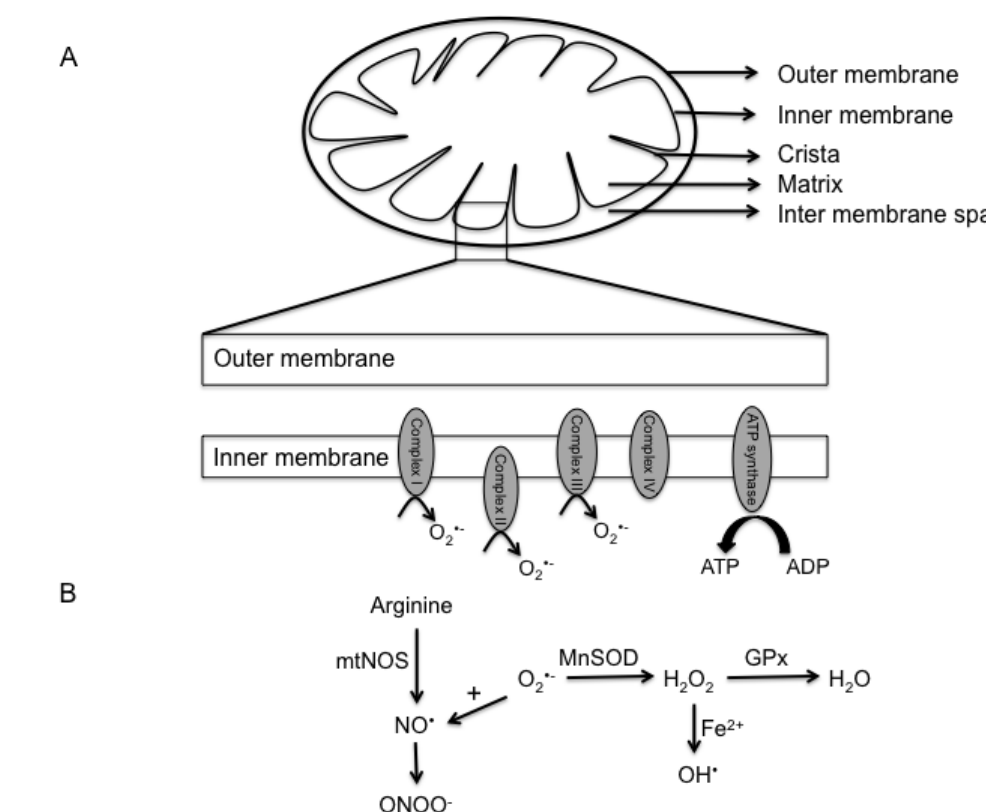
Figure 1. Mitochondria structure and generation of mitochondrial reactive species. ( A ) A schematic of a typical mitochondrion is represented. By virtue of its lipid bilayers, the mitochondrion can be subdivided into the outer membrane, inter-membrane space, inner membrane and matrix. The lower panel demonstrates the generation of superoxide anion through the different complexes of the electron transport chain; ( B ) Amplification of the free radical cycle. Superoxide generated during the electron transport chain can react with nitric oxide to form peroxy nitrite species. Alternatively, superoxide is converted by manganese superoxide dismutase to hydrogen peroxide, which is subsequently converted to water by glutathione peroxidase. In the presence of iron, hydrogen peroxide is rapidly converted to the highly reactive hydroxyl